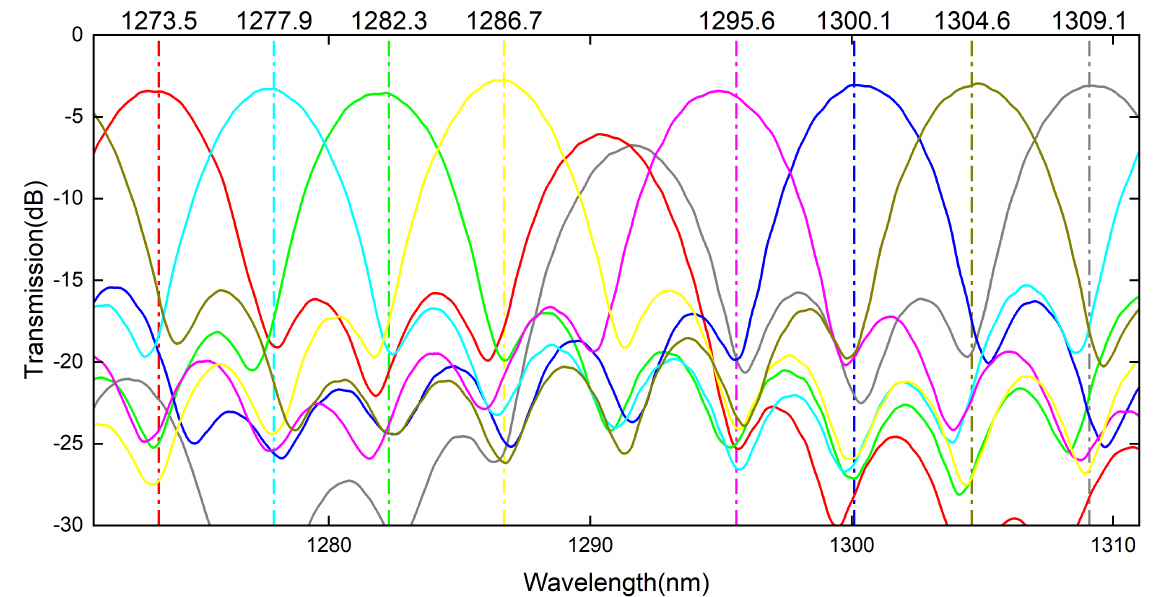
Figure 5. Measured transmission of the 8-channel